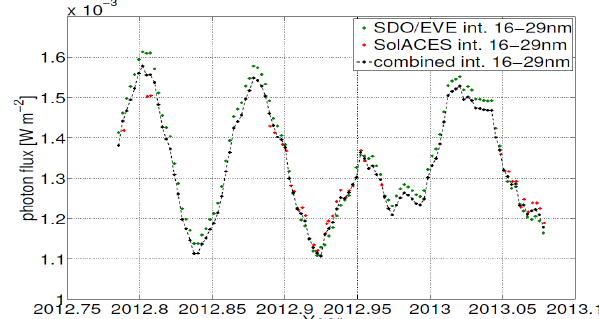
Figure 34: Combined EUV data set from the SDO/EVE and SOLAR/SolACES Figure 34. Combined EUV data set from the SDO/EVE and SO- instruments covering four solar rotations (with courtesy of B. Nikutowski and Ch. Erhardt). LAR/SolACES instruments covering four solar rotations (courtesy of B. Nikutowski and Ch. Erhardt).